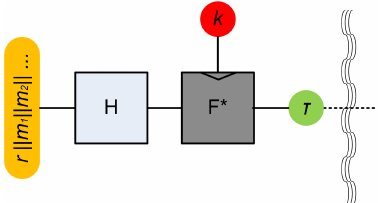
Figure 1: DTE leakage-resilient authenticated encryption (part